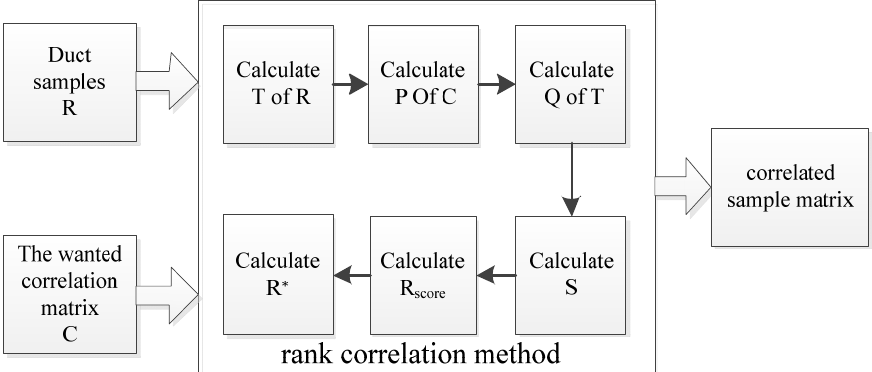
Figure 8. Flow chart of the rank correlation method.